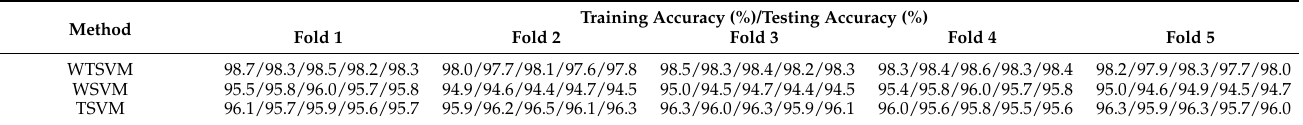
Table 4. Accuracy of the 3D-2D-1D-CNN-based WTSVM, WSVM, and TSVM